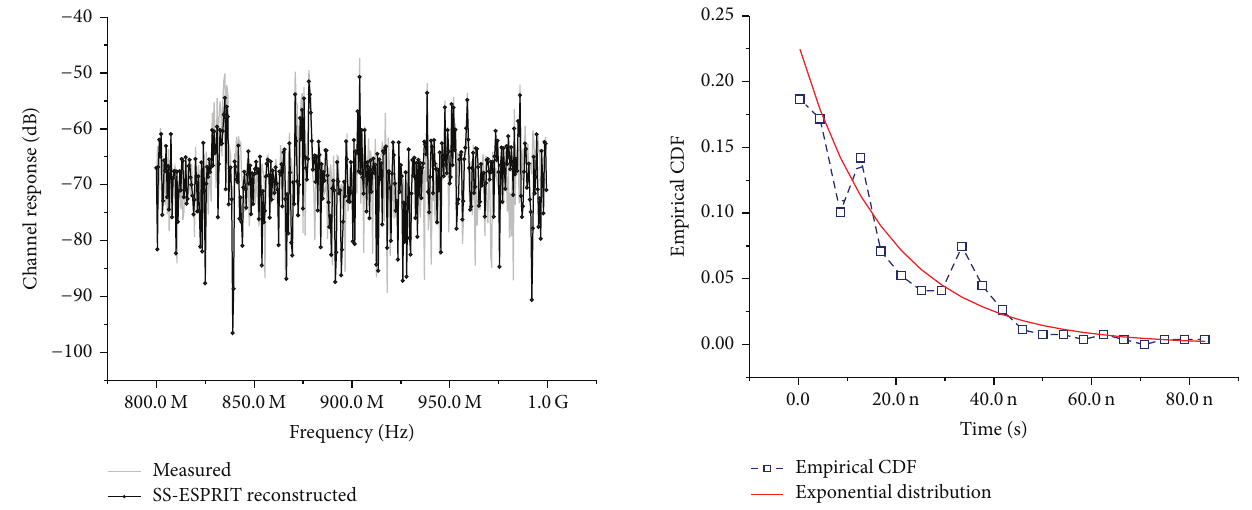
Figure 3: Comparison of the measured data and the SS-ESPRIT reconstructed signal in Scenario 1.